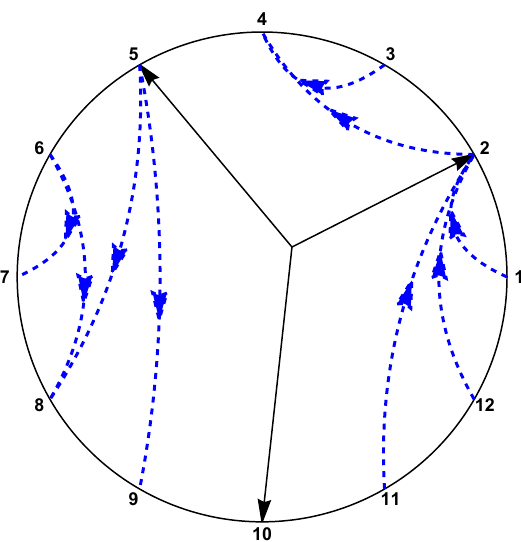
Figure 5 . An arc diagram (with a counter-clockwise orientation) for the product of three amputated currents: that is, for the smoothly split n = 10 particle partial biadjoint scalar amplitude, according to the triple (2,5,10), into a product of three currents. The (non-amputated) currents would include the three directed arcs (2 → 5) , (5 → 10) and (10 → 2) . Arcs are directed to indicate that the planar pole should be constructed from the particle labels on the segment of the (counter-clockwise directed) circle that is parallel to the directed